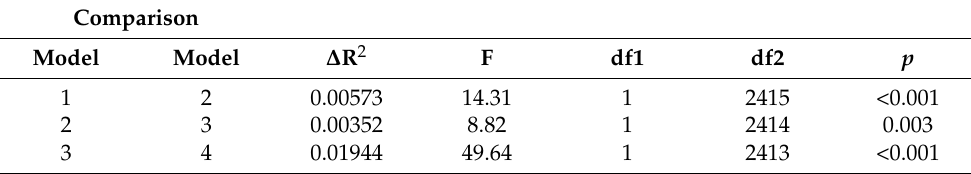
Table 5. Multiple linear regression model